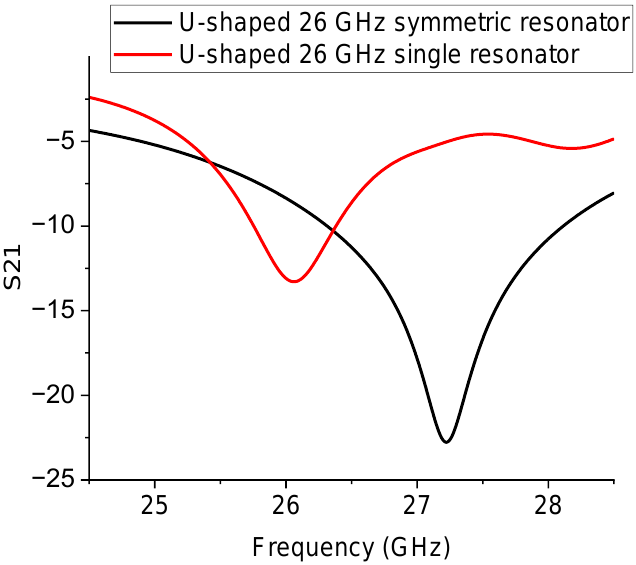
Figure 13. Comparison of the simulated 26 GHz resonators: the single and the mirrored configura- tion.